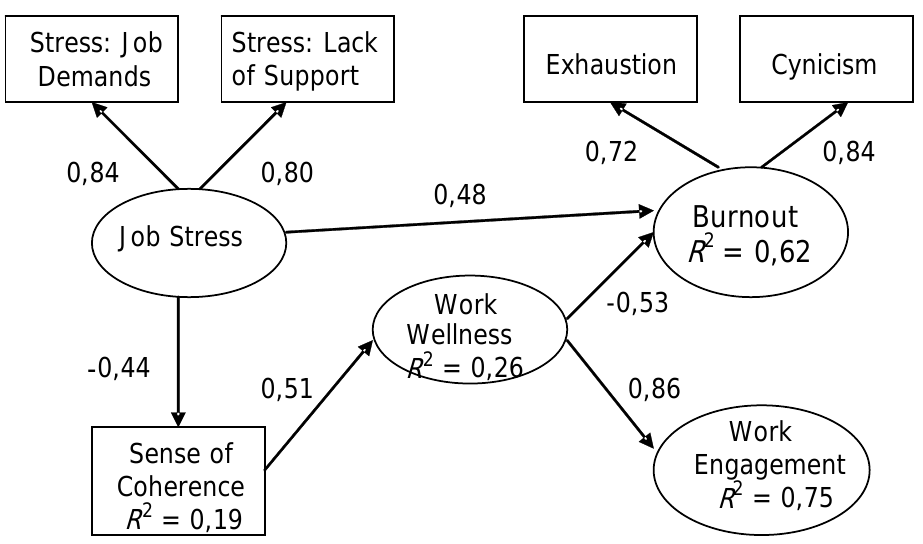
Figure 1. Maximum likelihood estimates for the model of work wellness, N = 215 (standardised solution). (Note: All factor loadings and path coefficients are significant, p <